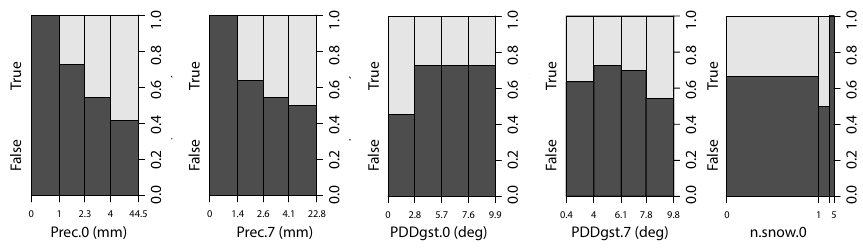
Figure 8. Spineplots for periods during the snow-free period of R7c for selected variables (see Table 3) showing frequencies of the occurrence of a peak (light grey) as opposed to the absence (dark grey) of a peak conditional in relation to potential explanatory variables. Bar widths refer to the 25% quantiles of the explanatory variables, except for new snow (n.snow). Note: spineplots for all potential explanatory variables of both positions (R2b and R7c) during the snow cover and snow-free period can be found in the Supplement to this paper (Figs. S2 and S3).